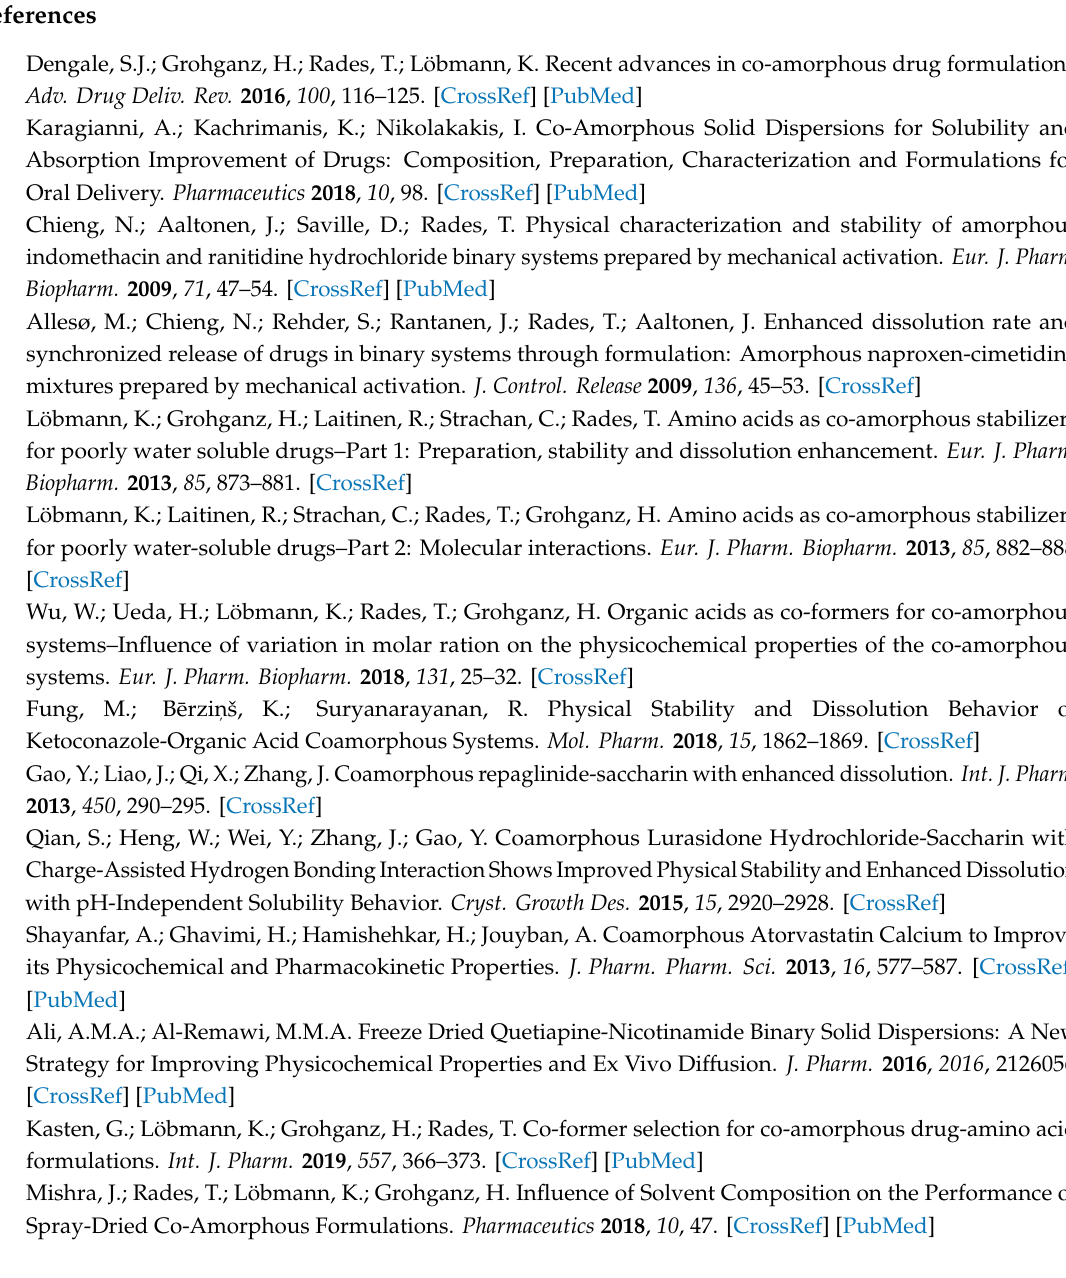
Table S1: Solubility of di ff erent APIs in combination with surfactant and AA, Table S2: Overview of all compositions freeze-dried for further investigations, Figure S1: Solid state of starting materials, Figure S2: Solid state of freeze-dried concentrations at low and high concentration of detergents, Figure S3: Solid state upon 18 weeks of